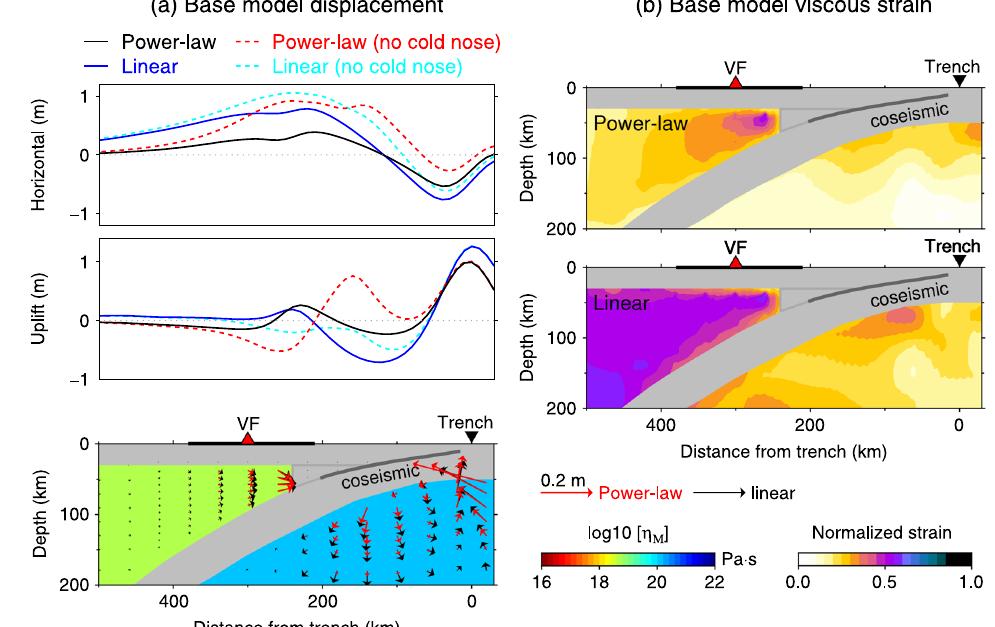
Fig. 4 The effect of base viscoelastic model on the 3-year postseismic deformation. a The surface displacement by base viscoelastic models with linear and power-law rheology. The surface displacements by base model without cold nose are illustrated by dotted lines. The 2-D viscosity profile depict the basic viscoelastic model with uniform viscosities for upper mantle and oceanic mantles. The flow vectors for power-law and linear model are also illustrated. b The viscous strains calculated over 3 years of postseismic deformation in the power-law and linear base models. The strain distribution is normalized by coseismic strain perturbation (normalized strain total strain / coseismic strain change). Viscous strain is defined as the = second invariant of the deviatoric strain